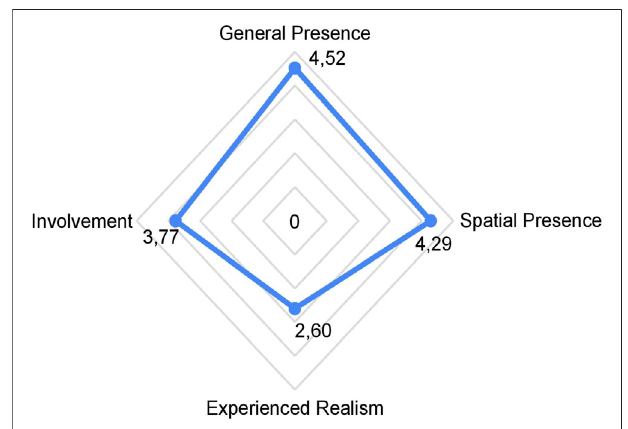
FIGURE 5 | iGroup Presence Questionnaire Evaluation. Note: iGroup Presence Questionnaire Evaluation with means of the subscales involvement, experienced realism, spatial presence, and general